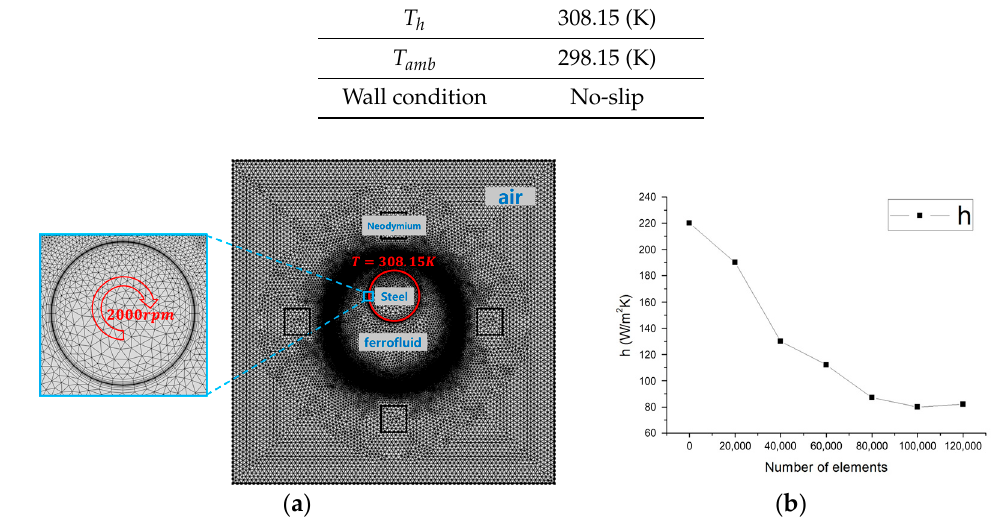
Figure 2. Schematic of the boundary conditions. ( a ) Grid systems; ( b ) Grid dependency test.